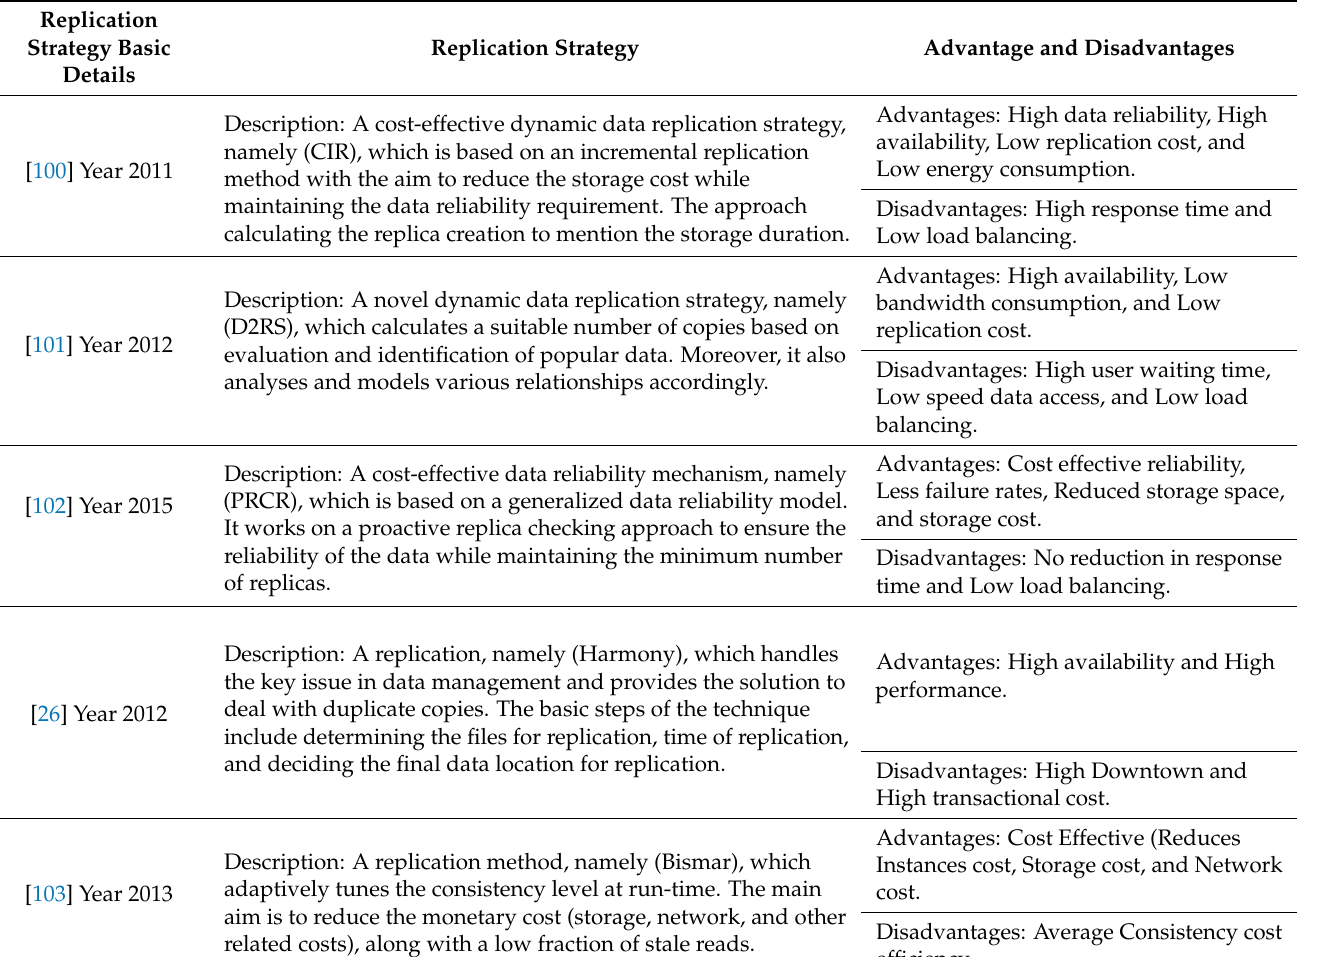
Table 3. Literature review of target-oriented replication